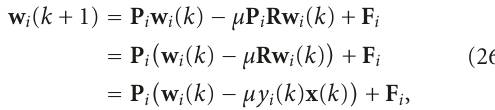
LMS algorithm based on the received data samples. As a gradient-descent algorithm, constraint LMS